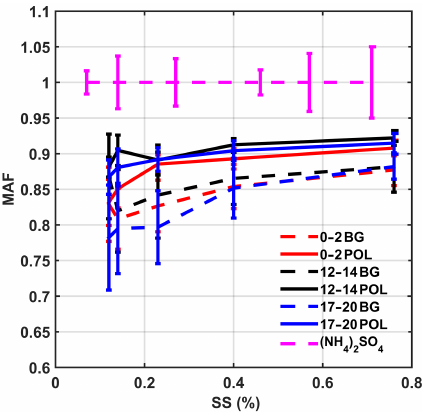
Figure 5. Mean maximum active fractions (MAFs) of CCN activa- tion spectra under polluted (POL) and background (BG) conditions during the three periods of interest (00:00–02:00, 12:00–14:00, and 17:00–20:00LT). The MAF of pure (NH 4 ) 2 SO 4 particles at the dif- ferent SS levels (magenta line) is also